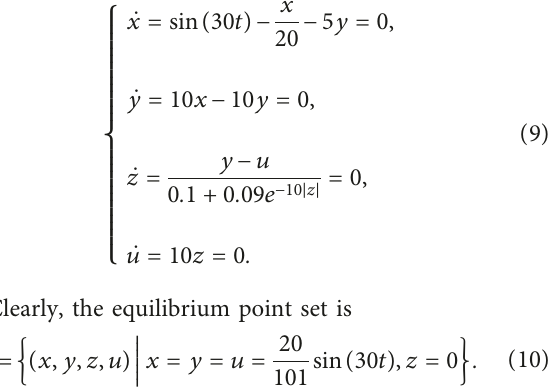
Figure 4: Waveform drawing of state variable: (a) Voltage of C; (b) current flow of inductor L inductor L 2